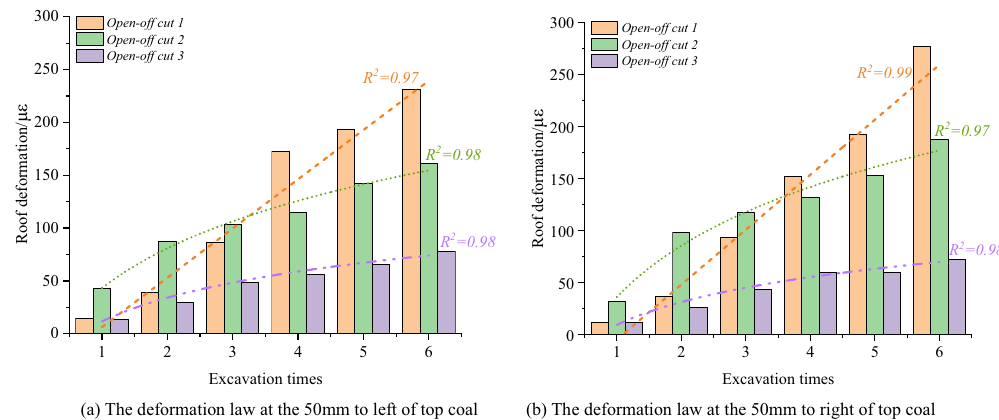
Figure 13. The deformation law of roof fall warning